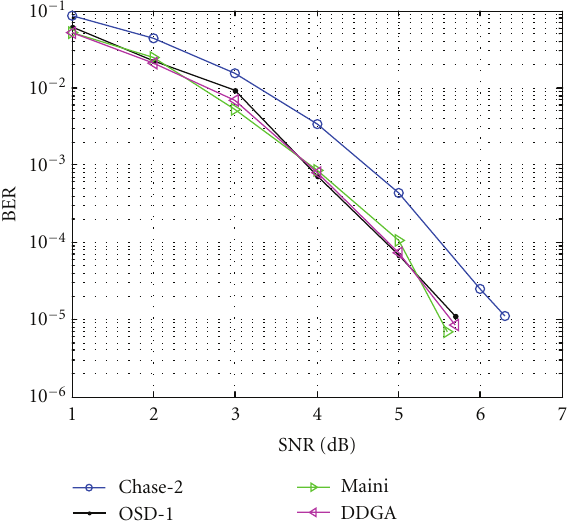
Figure 12: Performances of Chase-2, OSD-1, Maini, and DDGA algorithms for BCH (31,21,5) code.